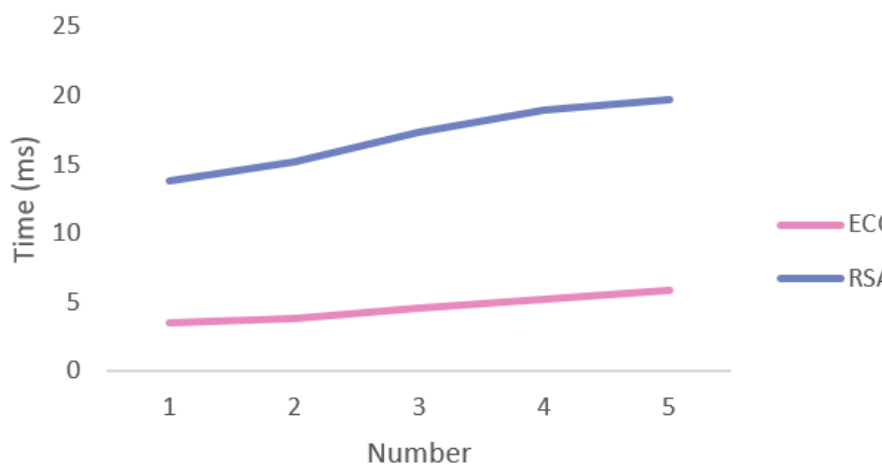
Figure 9. Time complexity comparison of algorithms. Table 7. Performance comparison of ECC and RSA.